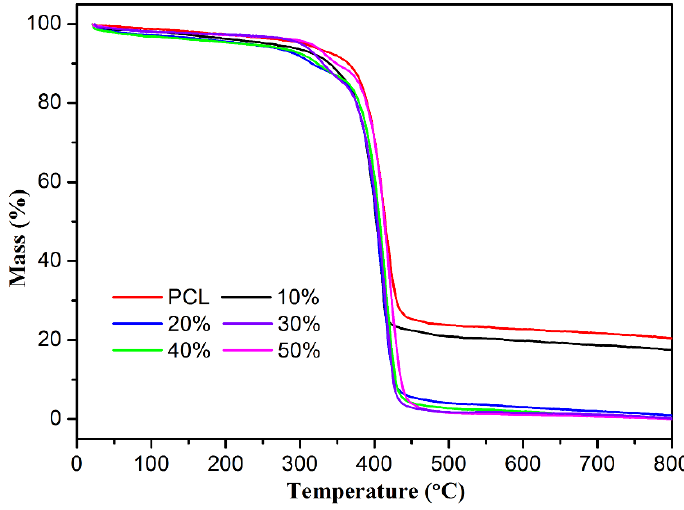
Figure 3. TG curves of neat PCL fibers and composite fiber composites.